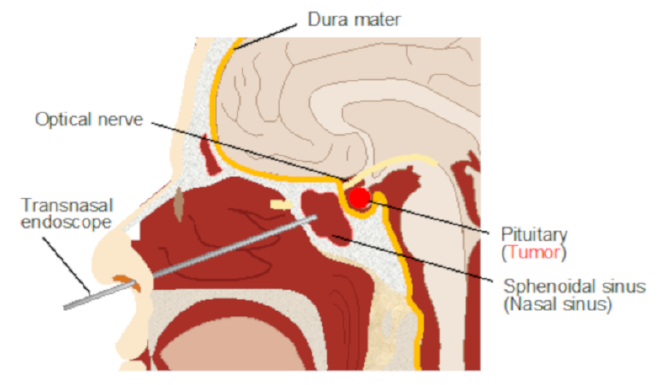
Figure 1. Sagittal view of the brain and its structures with a transnasal endoscope for